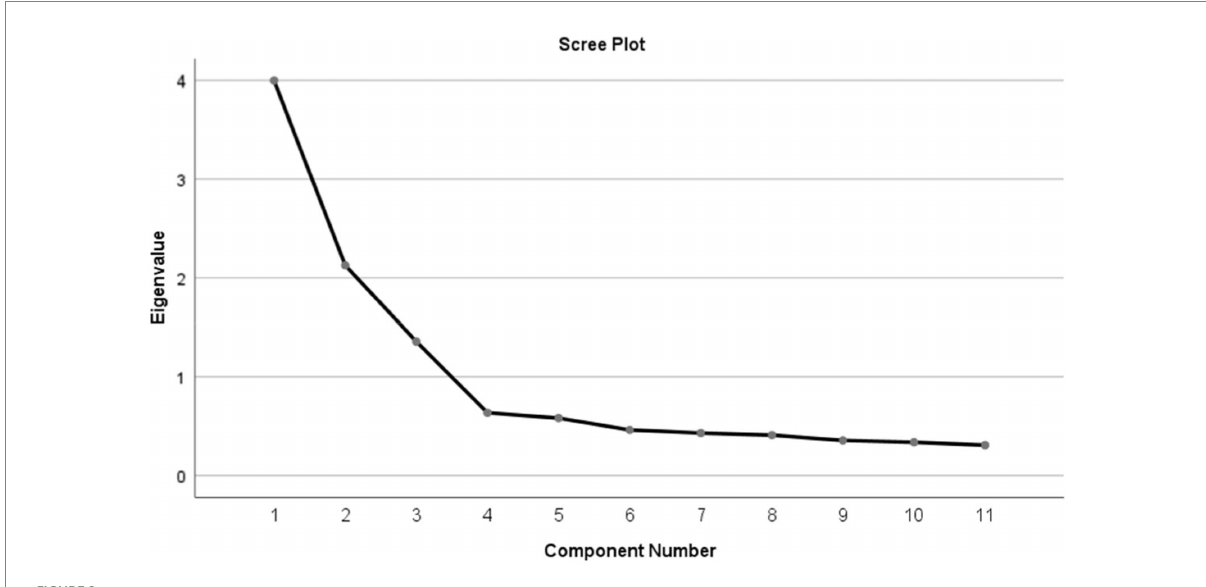
FIGURE 2 Screen plot of exploratory factor analysis for Chinese version of the ATREND.